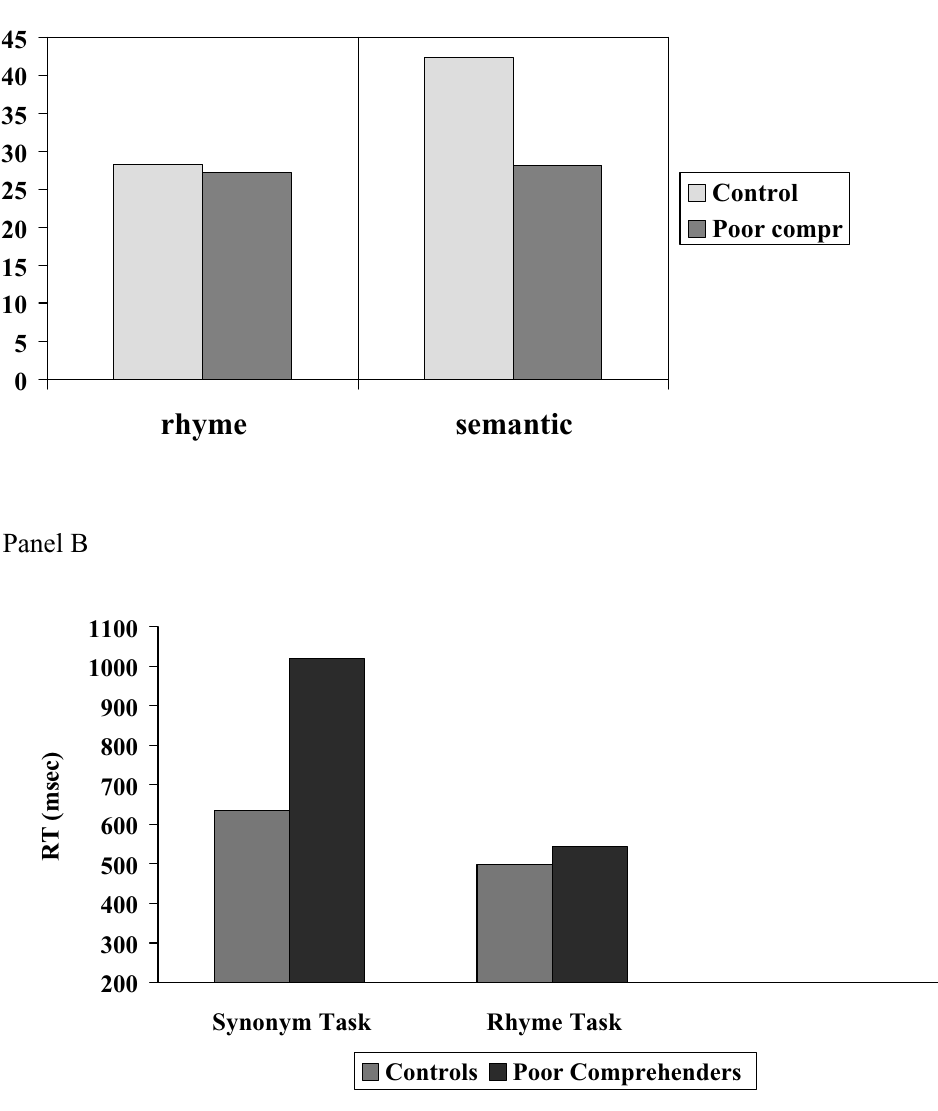
Figure 4. Panel A. Performance of poor comprehenders on a test of oral fluency. The poor comprehenders showed normal rhyme fluency but impaired semantic fluency. Panel B. Performance of poor comprehenders on aural tests of synonym and rhyme judgement. The poor comprehenders showed normal rhyme but impaired semantic judgements (after Nation & Snowling,